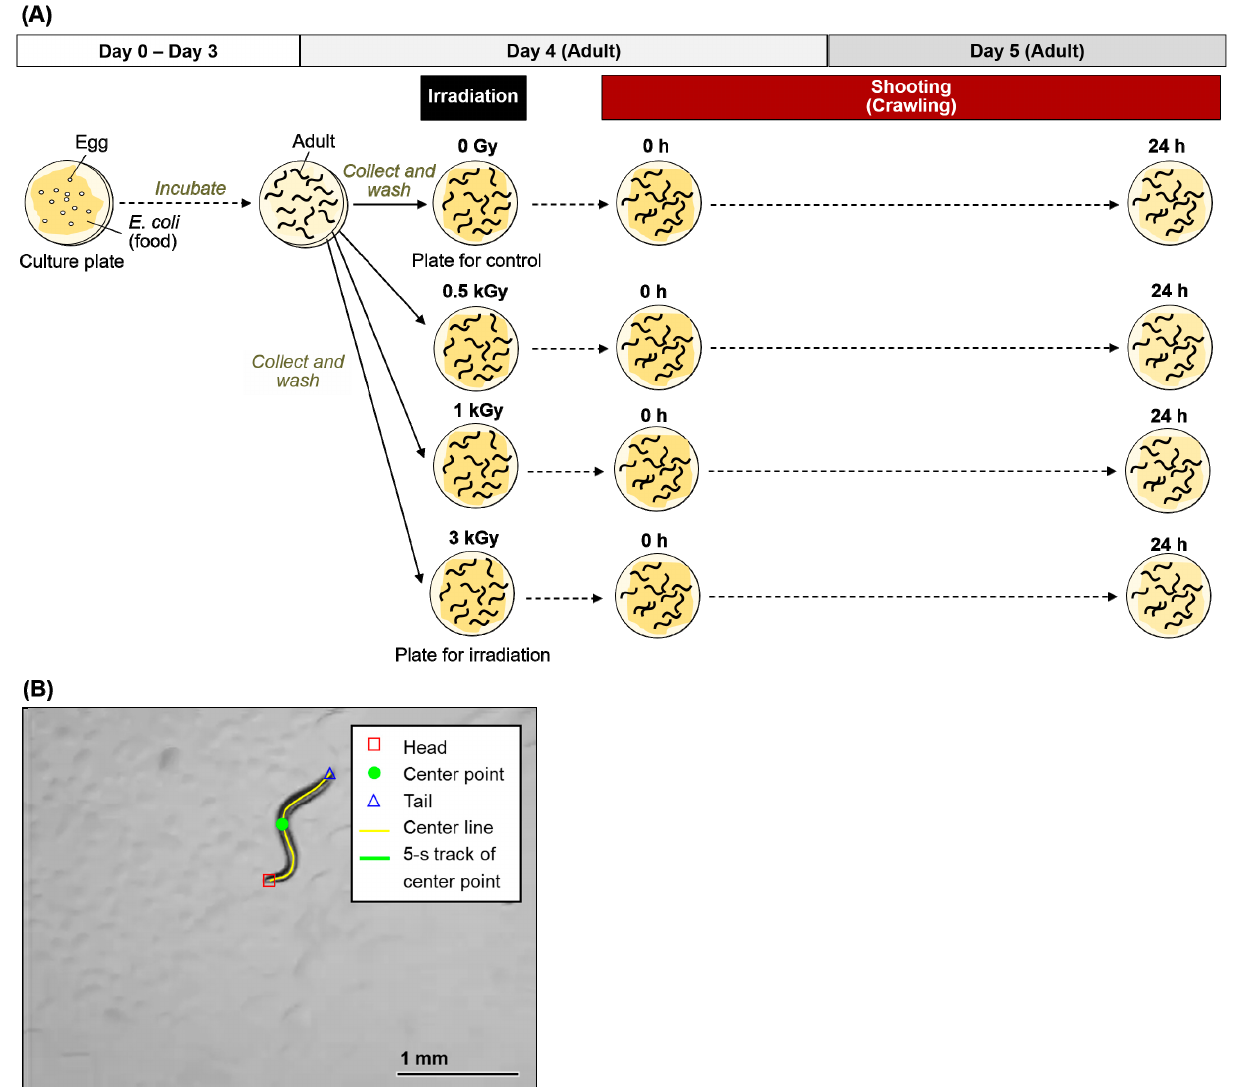
Figure 2. Procedure for crawling assay of C. elegans after γ -ray or carbon-ion whole-body irradiation. ( A ) The scheme of this experiment. Well-fed adult worms were irradiated with γ -rays or carbon-ion beams. After irradiation, the crawling of 5 worms, which were randomly selected from worms on NGM plates spread with a bacterial lawn, were video-recorded. The procedure was conducted through independent irradiation trials, i.e., 6 irradiation trials for γ -rays and 4 trials for carbon-ion beams, respectively. Thirty worms were tested in each condition in 6 trials of γ -rays irradiation (5 worms per condition per trial). Twenty worms were tested in each condition in 4 trials of carbon-ion irradiation (5 worms per condition per trial). ( B ) An example of image processing for analysis of crawling in C. elegans on agar. This image is a first scene (0 s) of forward motion of a non-irradiated (0 Gy) wild-type worm, and the red square, green circle, blue triangle, and yellow line represent the head, center point, tail, and center line, respectively. The green line shows the 5-s track length of center point. Values derived by image processing are as follows: mean worm length, which is mean of center line length for 5 s, was 1.185 mm; 5-s track length of center line was 2.194 mm; and 5-s track length/mean worm length was 1.85.